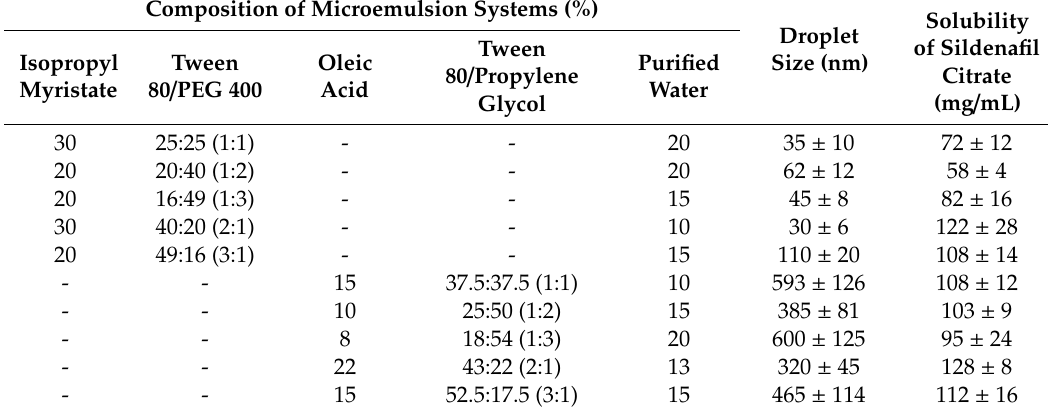
Table 3. Droplet size and saturated solubilities of sildenafil citrate in di ff erent microemulsion systems at room